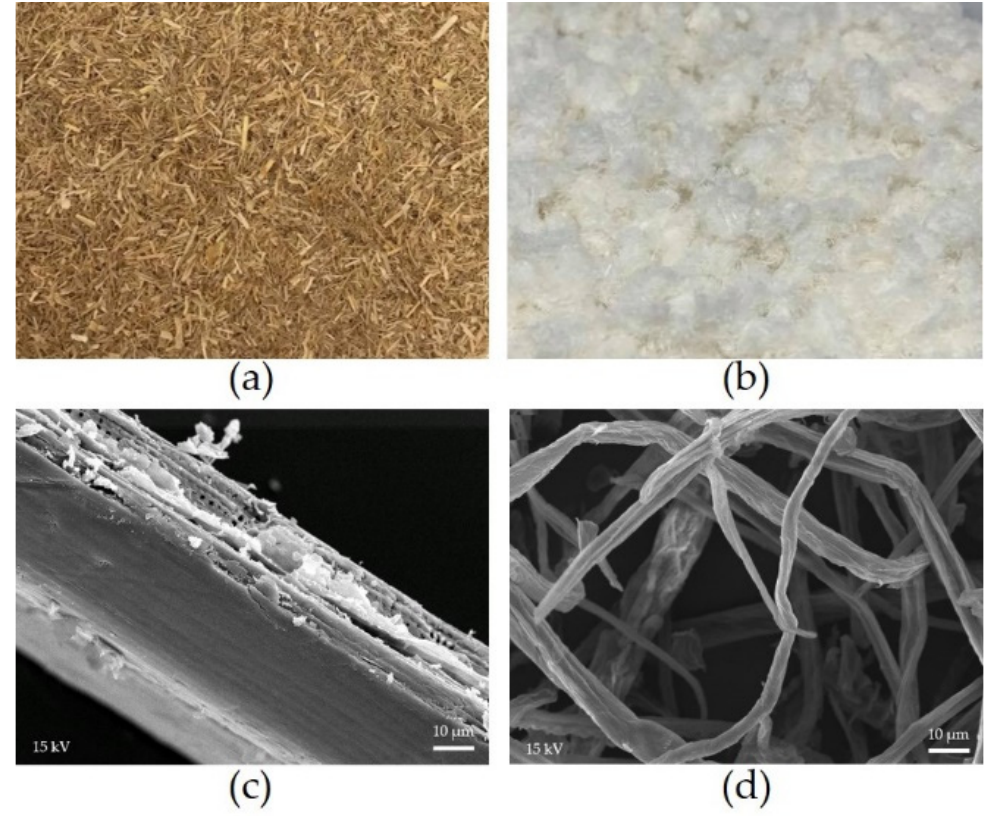
Figure 1. Appearances of ( a ) rice straw and ( b ) rice straw cellulose and SEM micrographs of ( c ) rice straw and ( d ) rice straw cellulose with 1000× magnification.